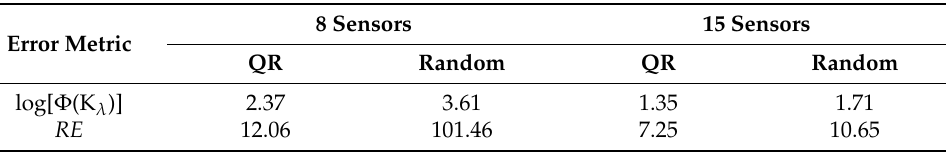
Table 6. Logarithm of condition number of K λ and relative reconstruction errors (%) of random placement and QR pivoting in velocity field (Boundary Condition 2). Log[ Ф (K λ )]